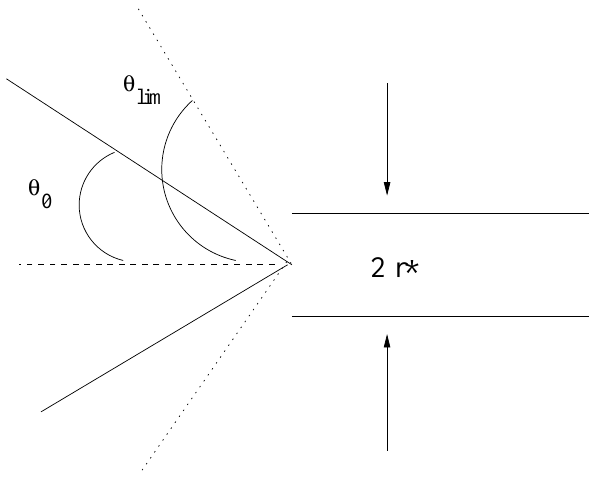
Fig. 1. Geometry and model parameters of a supersonic flow from a reservoir into vaccum (see Eq.